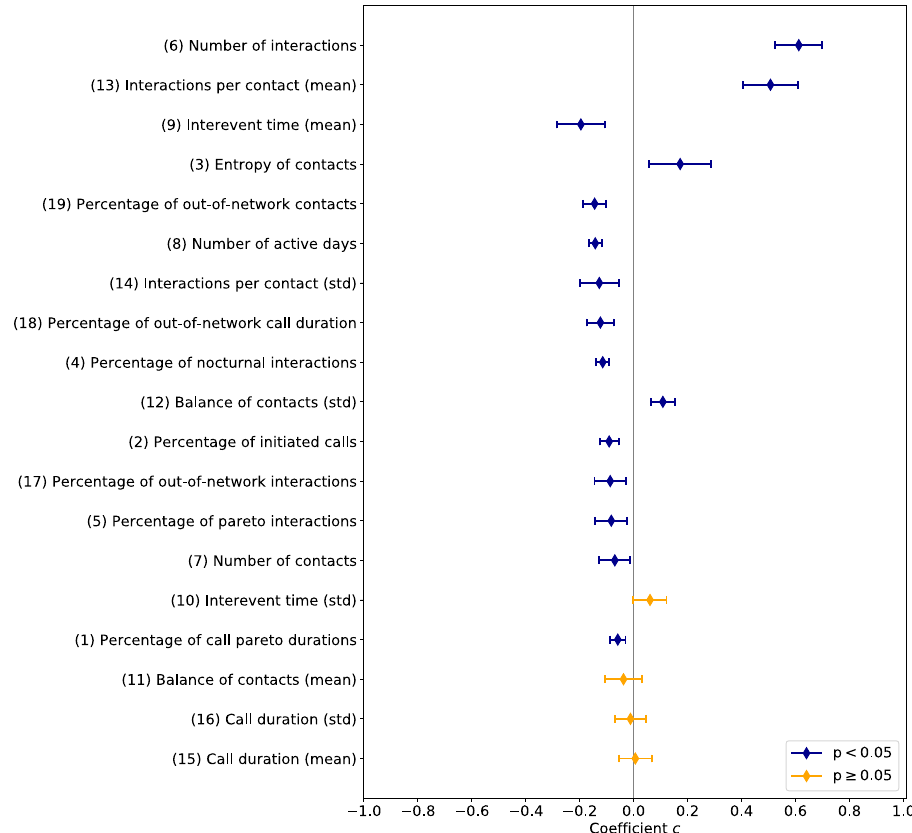
Fig. 6 Coef fi cients of logistic regression for individual identi fi ability. For each feature, we plot the coef fi cient c (with the 95% con fi dence interval) of a logistic regression classi fi er with whether a person is more or less identi fi able than expected as the dependent variable. Features are ordered decreasingly from top to bottom according to the absolute value of c . When holding all other features constant, these results suggest that having more interactions and a well-balanced interaction graph makes individuals more identi fi